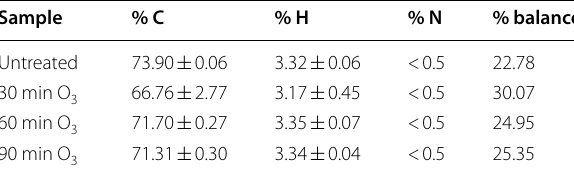
Table 2 Results of treated and untreated biochar samples for elemental analysis measured by percentages of C, H, N, and balance (the remainder elements including O and